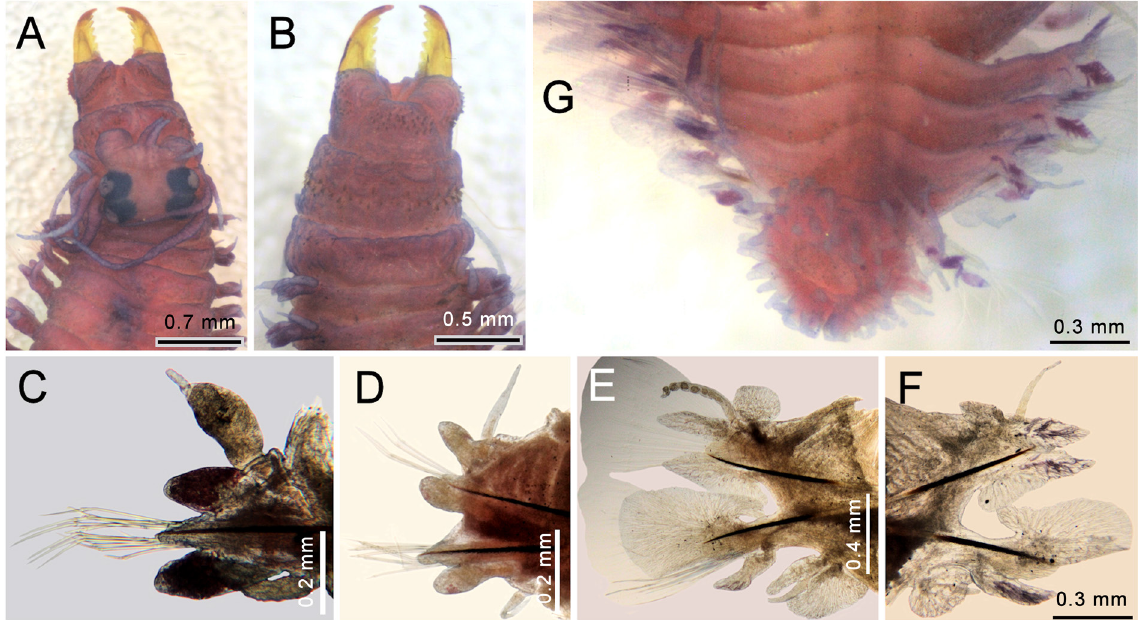
Fig. 4. Nereis splendida Grube, 1840, non-type, largest male epitoke (MNHN A83), after Shirlastain-A staining. A . Anterior region, dorsal view. B . Anterior end, ventral view. C . Chaetiger 2, right parapodium, anterior view. D . Chaetiger 15, right parapodium, anterior view. E . Chaetiger 30, right parapodium, anterior view. F . Chaetiger 74, right parapodium, posterior view (chaetae omitted). G . Posterior region, dorsal